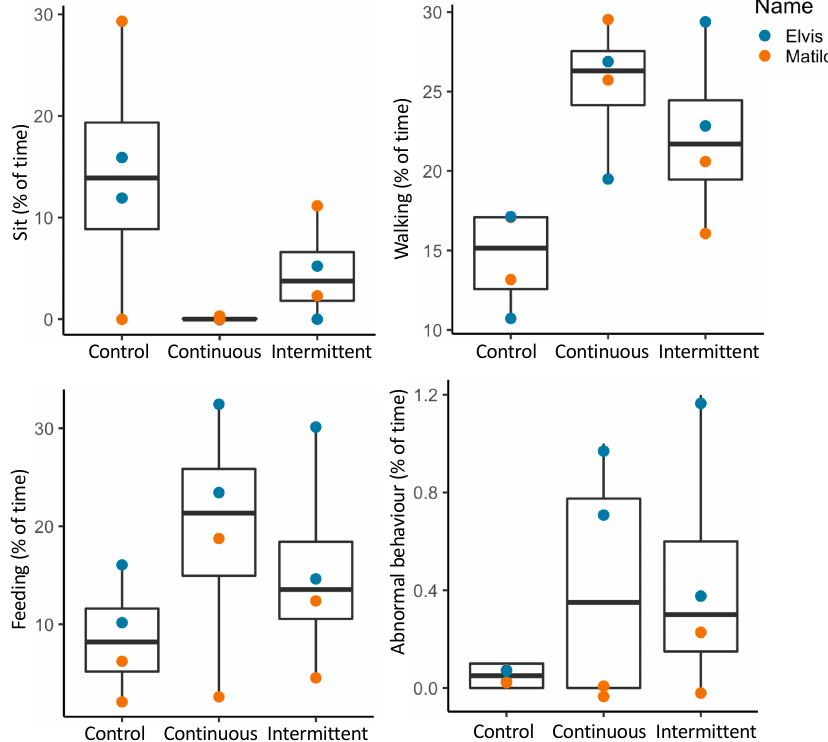
Figure 5. Boxplots of emu behavior in control, continuous and intermittent noise conditions with symbols identifying individuals.